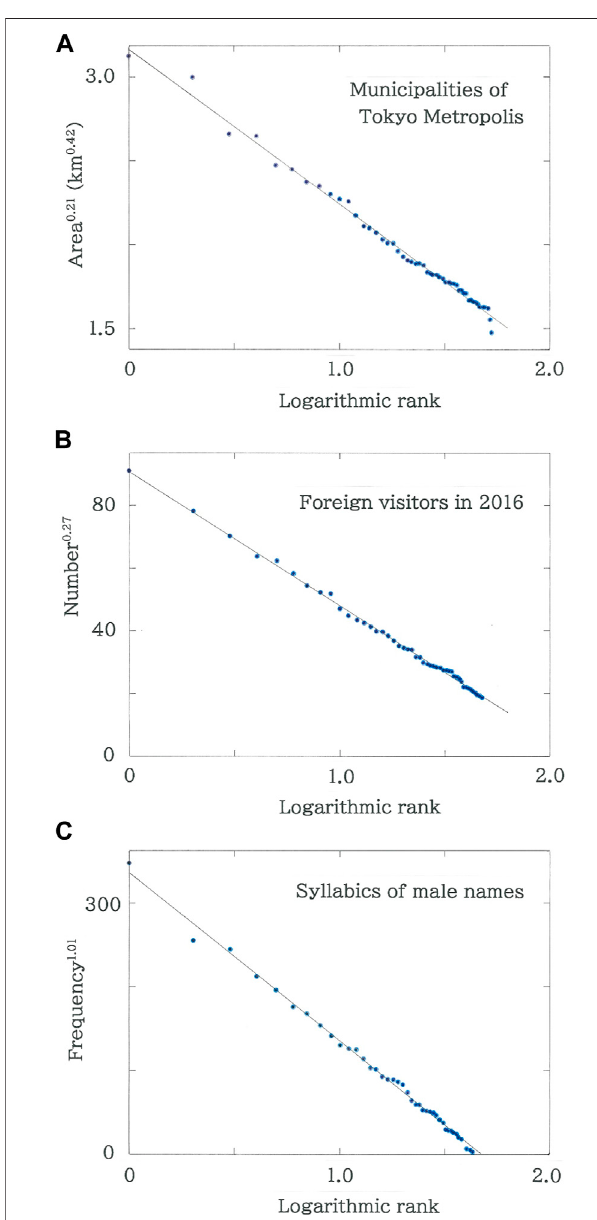
FIGURE 2 | Examples of rank-size rules. (A) Rank dependence of the areas of municipalities in the Metropolis of Tokyo. The line indicates the optimized fi t (| r | (cid:1) 0.9961 with d (cid:1) 1.861 for q (cid:1) 0.21 and n (cid:1) 53). (B) Rank dependence of the numbers of foreign visitors in the 47 Japanese prefectures (data from January to December, 2016). The line indicates the optimized fi t (| r | (cid:1) 0.9988 with d (cid:1) 1.160 for q (cid:1) 0.27 and n (cid:1) 47). (C) Rank dependence of the frequencies of Japanese syllabics in 1,000 male given names. The line indicates the optimized fi t (| r | (cid:1) 0.9977 with d (cid:1) 2.041 for q (cid:1) 1.01 and n (cid:1)